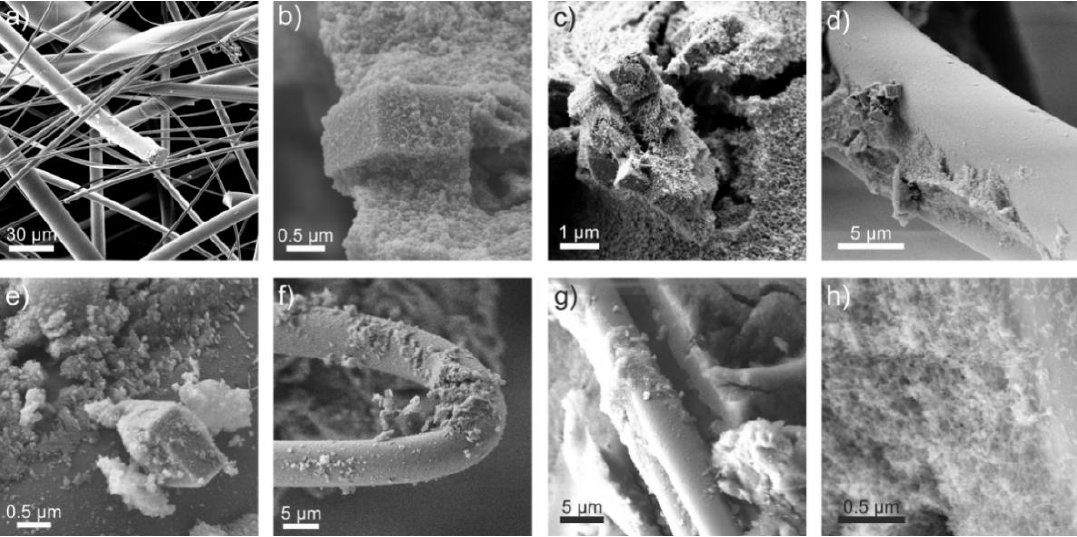
Figure 7. Representative SEM images of ( a ) a pristine glass fiber mat after heat treatment, ( b ) SA B30 composites after heat treatment, ( c , d ) FRSA–B30 composites before heat treatment and ( e – h ) after heat treatment at different magnifications.